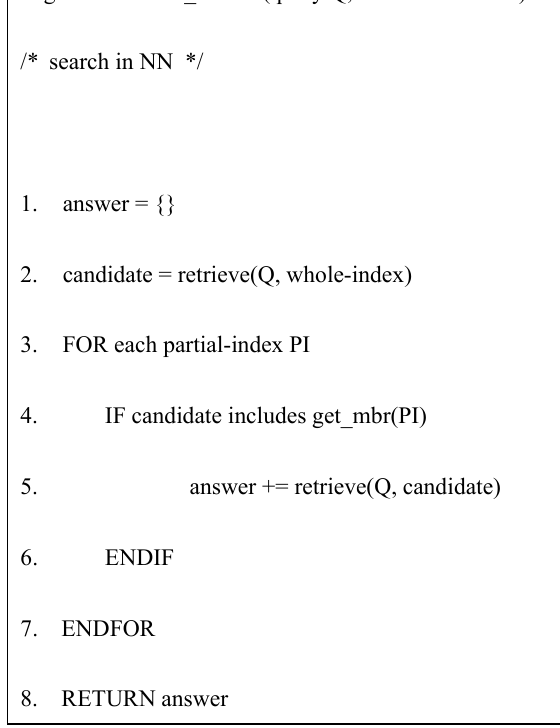
Fig. 7. The algorithm of search at a